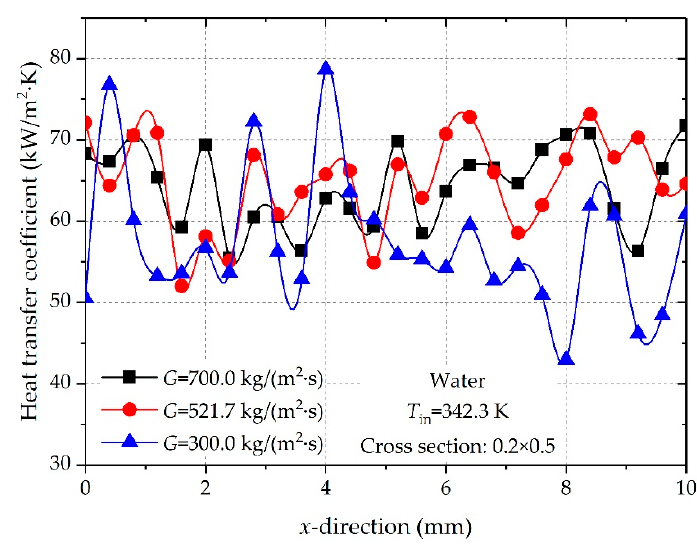
Figure 7. Variations in the local heat transfer coefficient along the flow stream for different mass fluxes.